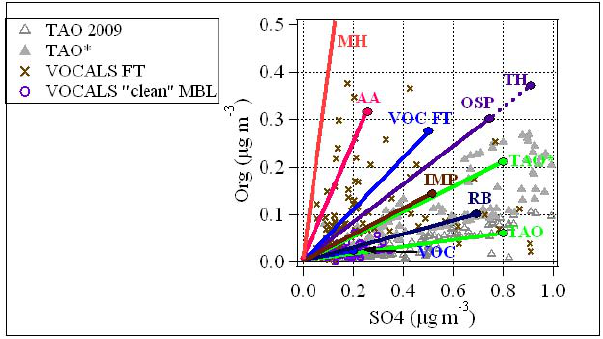
Fig. 7. AMS organics (Org) versus sulfate (SO 4 ) during TAO 2009 cruise, VOCALS “clean” MBL (VOC), and VOC FT. Also shown are approximate implicit slopes for the Org/SO 4 relationship from Trinidad Head (TH), Mace Head (MH), Ace-Asia (AA), IMPEX (IMP), Ocean Station Papa (OSP), and VOCALS Ron Brown (RB). Average reported clean values are shown as filled, colored circles, and the line drawn from the origin to the reported average is the implicit slope. Excursions from the TAO average Org/SO 4 of 0.08 are indicated as